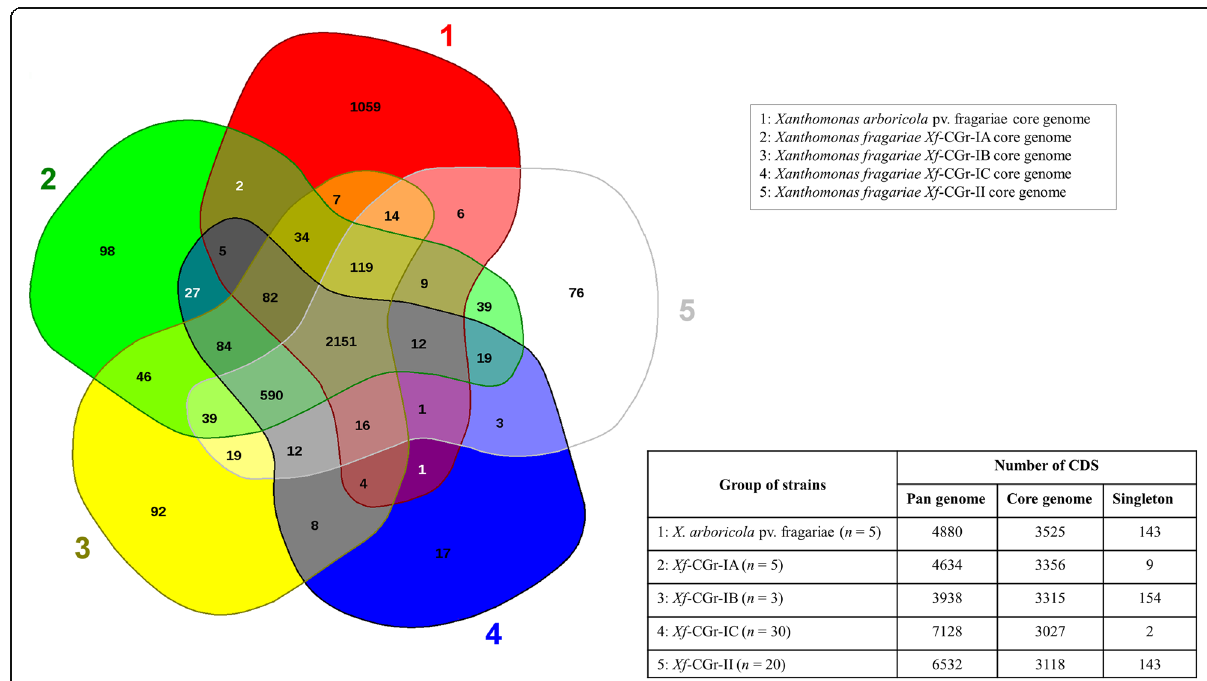
Fig. 1 Five-way genome comparison. Five-set Venn diagram constructed using EDGAR (Blom et al. 2016) and visualizing the common gene pools among the core genomes of 1) Xanthomonas arboricola pv. fragariae, 2) Xanthomonas fragariae CRISPR group IA ( Xf -CGr-IA), 3) Xf -CGr-IB, 4) Xf - CGr-IC and 5) Xf -CGr-II. The numbers indicated in the diagram correspond to the amounts of CDS. The table summarize the pan genome, core genome and singleton information in each X. fragariae (sub)group and in X. arboricola pv.